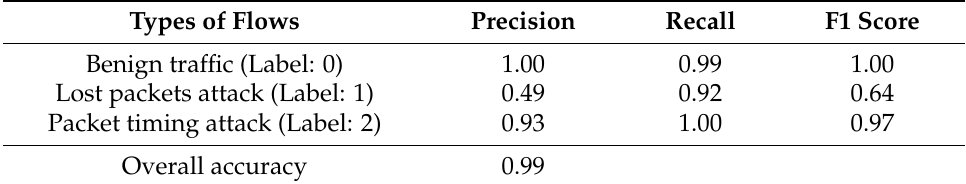
Table 7. Performance of RF classifier in terms of precision, recall, F1 score, and overall accuracy metrics.